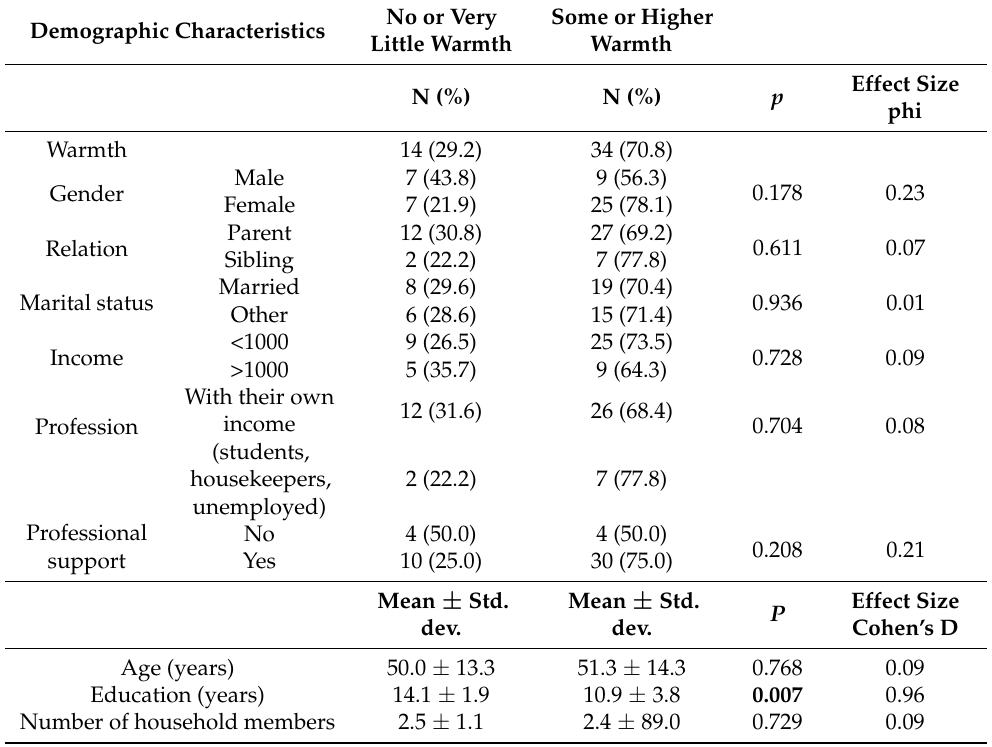
Table 3. Demographic characteristics of the relatives based on the level of warmth towards the patient (N = 48).